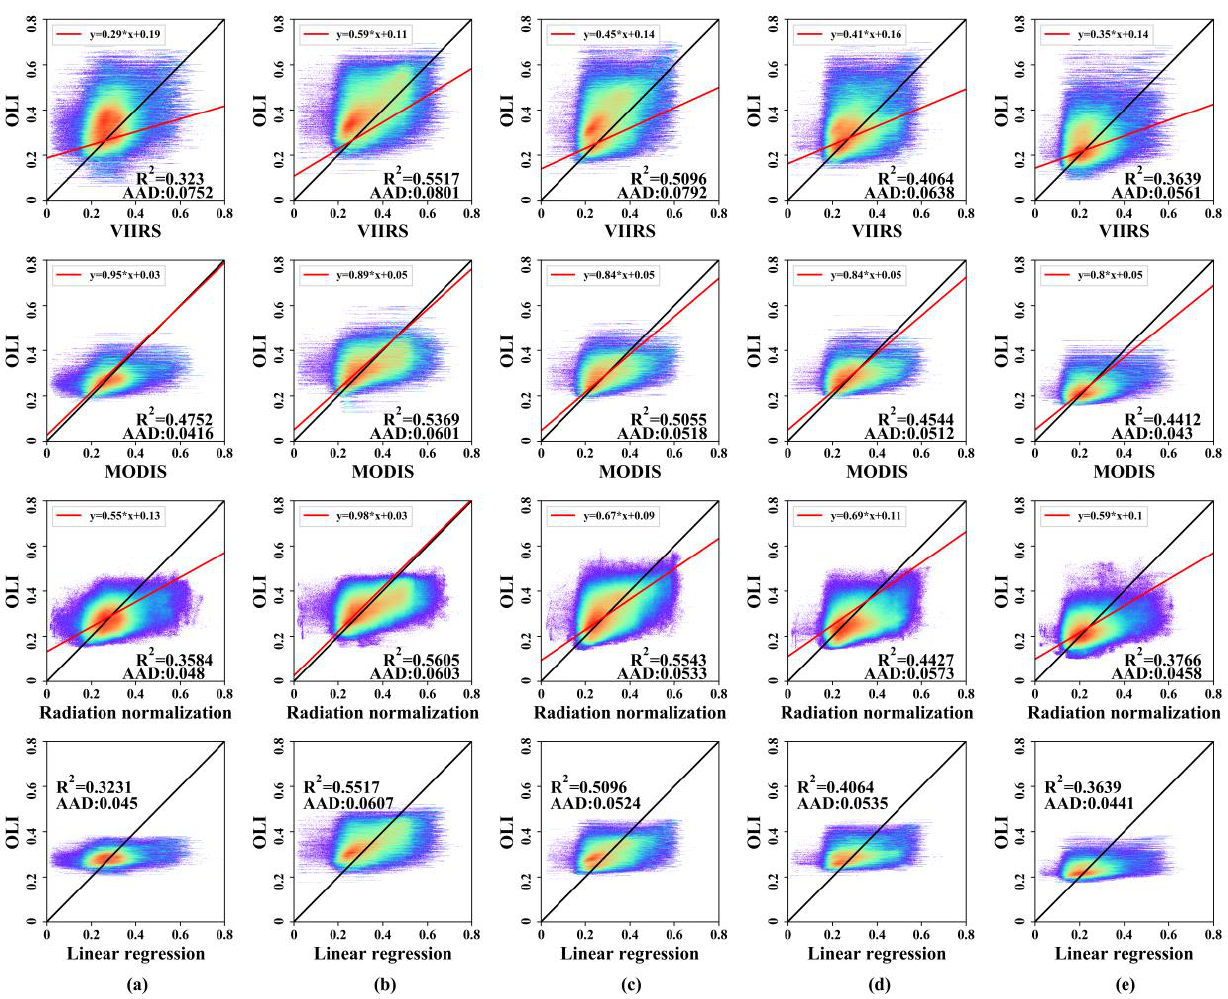
Figure 11. Scatter plots of Landsat OLI’s Band 4 on the y-axis, and I1 of VIIRS, Band 2 of MODIS, and radiation normalization on the x-axis. (a) 02 Jun 2019, (b) 20 Jul 2019, (c) 06 Sep 2019, (d) 22 Sep 2019, (e) 08 Oct 2019.